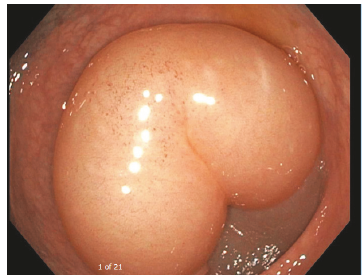
Figure 2: Colonoscopy during an acute attack showing severe mucosal edema in the transverse colon with occlusion of the